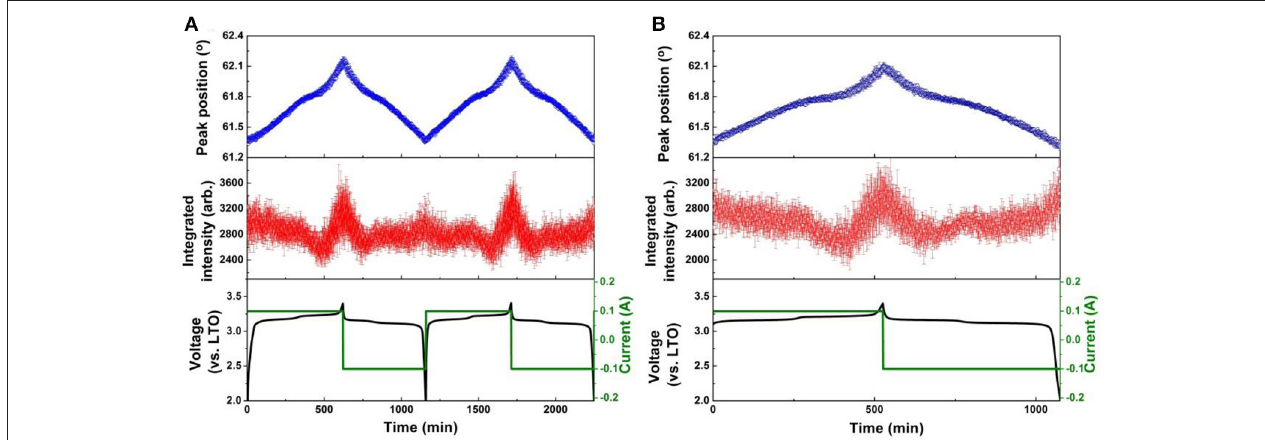
FIGURE 8 | Results of single peak fitting of the LNMO 222 reflection of NPD data for the LNMO||AlF 3 -LTO battery, including peak position and intensity, for (A) the first two cycles, and (B) the 51st cycle. Battery voltage and current are also